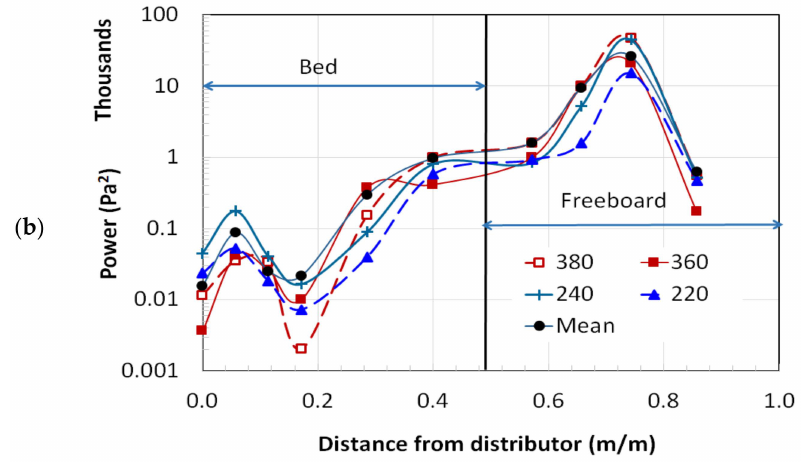
Figure 10. Power distribution of sound waves along the column length for ( a ) empty column and